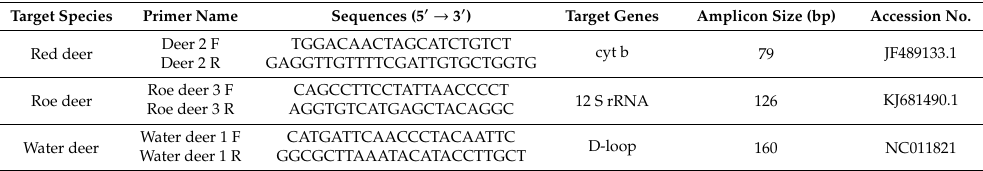
Figure 1. The sequence alignment of red deer ( A ), roe deer ( B ), and water deer ( C ) specific primers in the mitochondrial cytochrome b, 12 S rRNA, and D-loop regions against various animal species. Table 1. Primers used in this